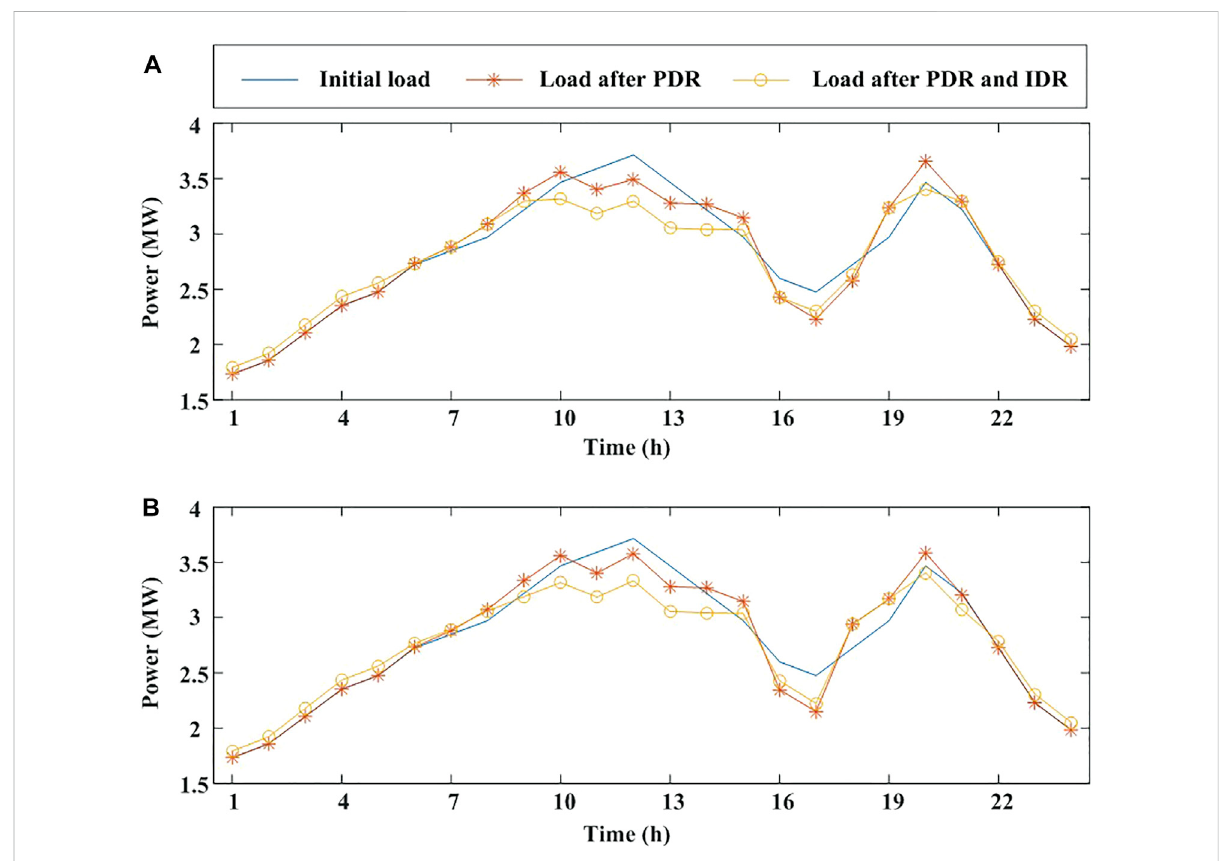
FIGURE 3 Load curves: (A) Γ wind = 0 (B) Γ wind =